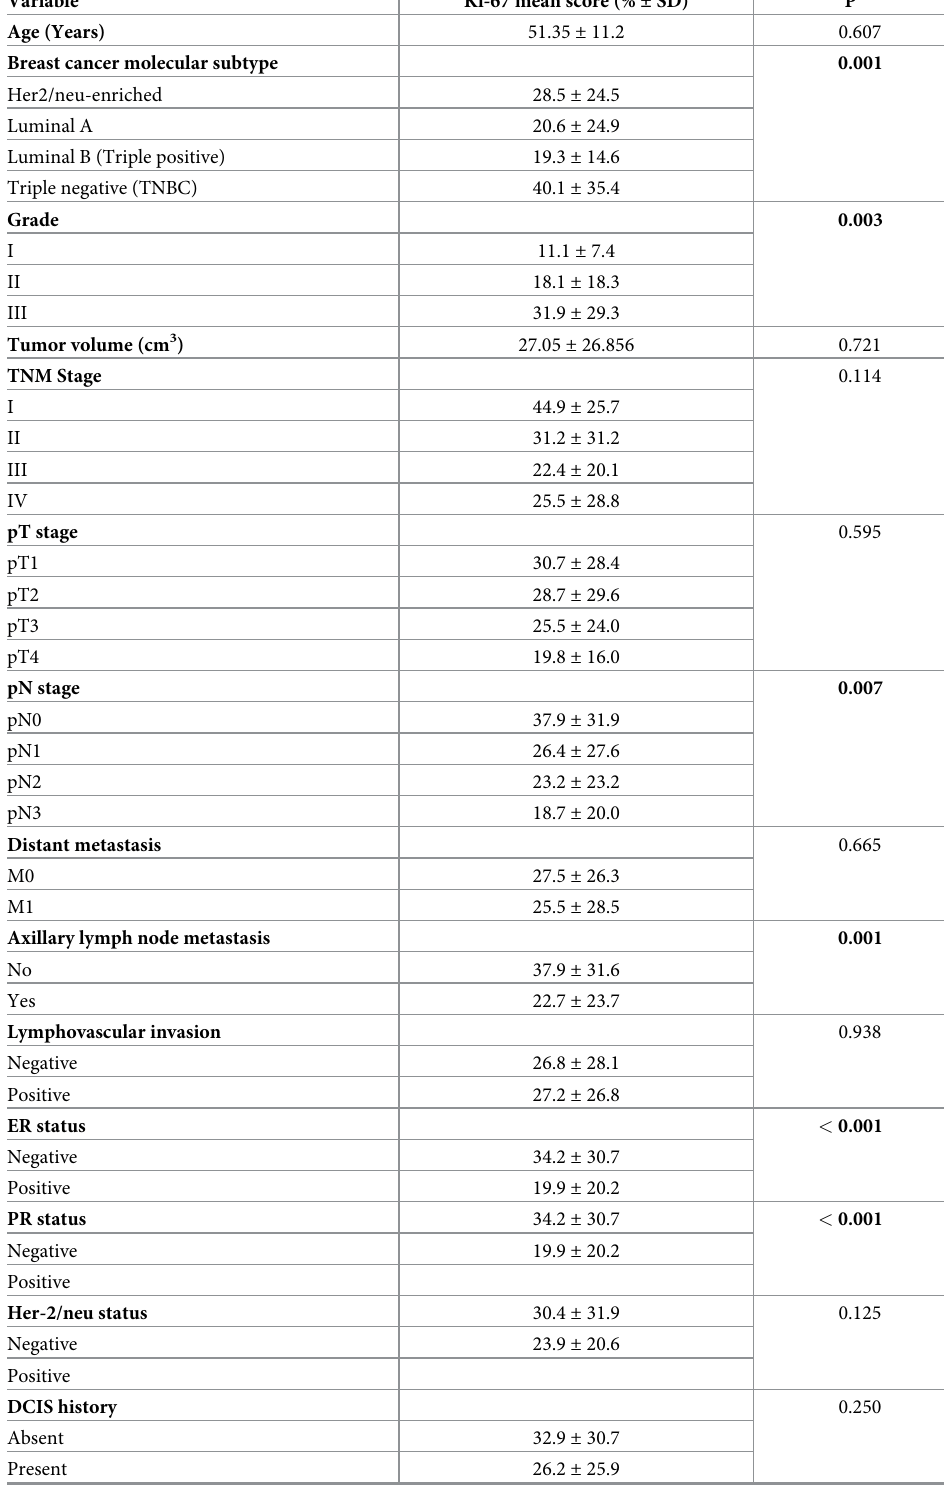
Table 3. Clinicopathological features of breast cancer patients in relation to Ki-67